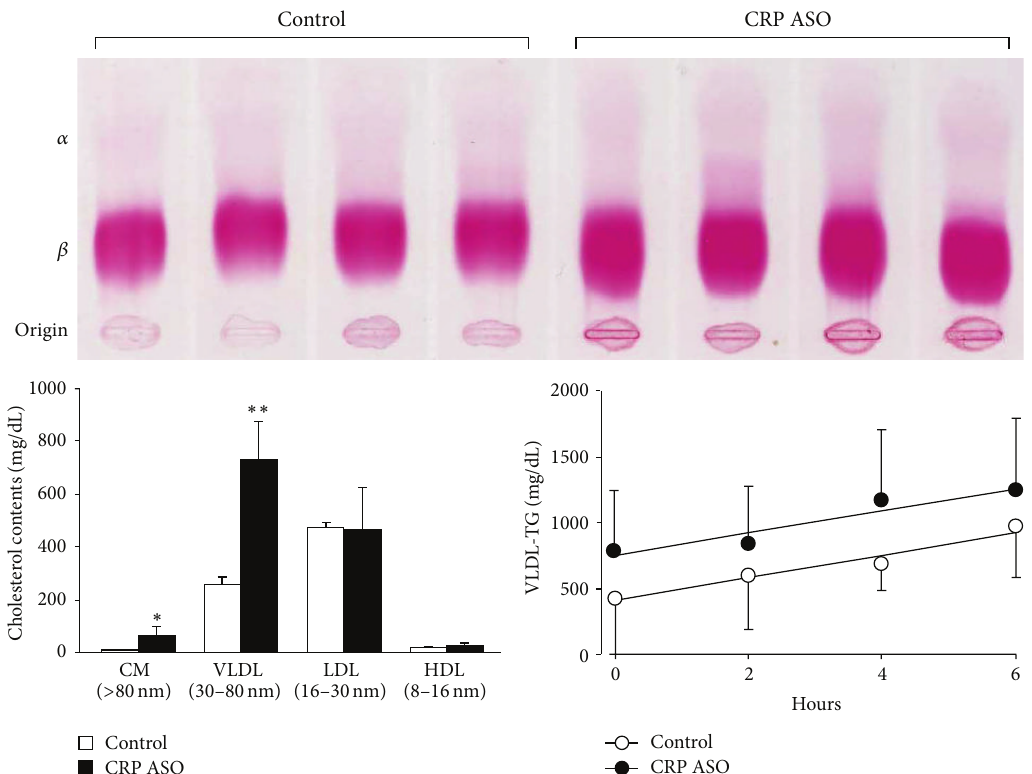
Figure 3: Analysis of lipoprotein profiles. Lipoprotein profiles were analyzed by agarose gel electrophoresis (top) and HPLC (bottom left). Post-Triton VLDL production rate in fasting rabbits was measured. Blood was drawn at 0 minutes (before administration of Triton WR-1339) and 2, 4, and 6 hours after Triton WR-1339 injection. VLDL-TG ( 𝑑 < 1.006 g / mL) contents were quantified (bottom right). ASO-treated rabbitsshowedincreasedlevelsof 𝛽 -migratingparticles(bothVLDLandchylomicronremnants)attheorigin.VLDLsynthesisrate(expressed by the slope of each line) was the same in ASO-treated rabbits as in the control. Data are expressed as the mean ± SD ∗ or ∗∗ 𝑃 < 0.05 or 0.01 versus control. 𝑛 = 4 -5 for each group.